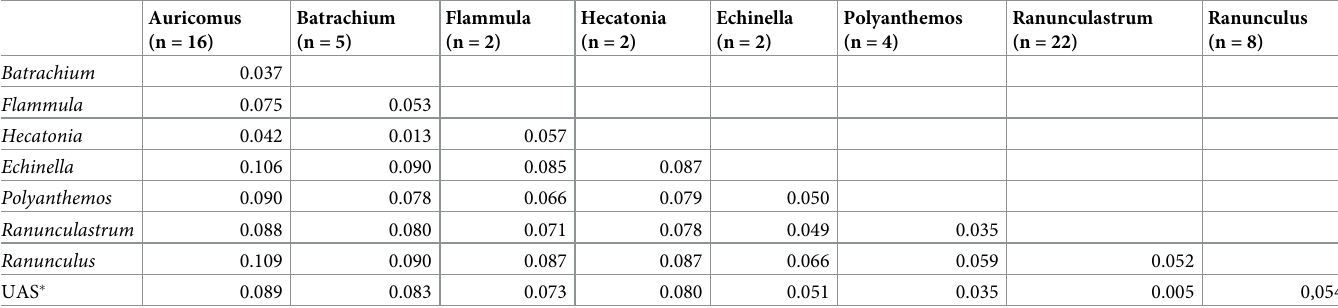
Table 2. The mean Nei’s genetic distances among samples from eight sections of the genus Ranunculus . Auricomus (n = 16)